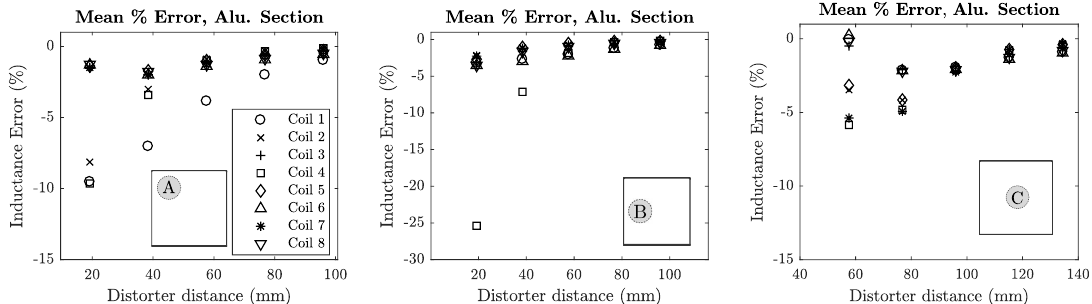
Figure 12. Mutual inductance error for planar sheet distorters. The Mu-metal sheet is the only material to consistently increase the mutual inductance of the transmitter coils.